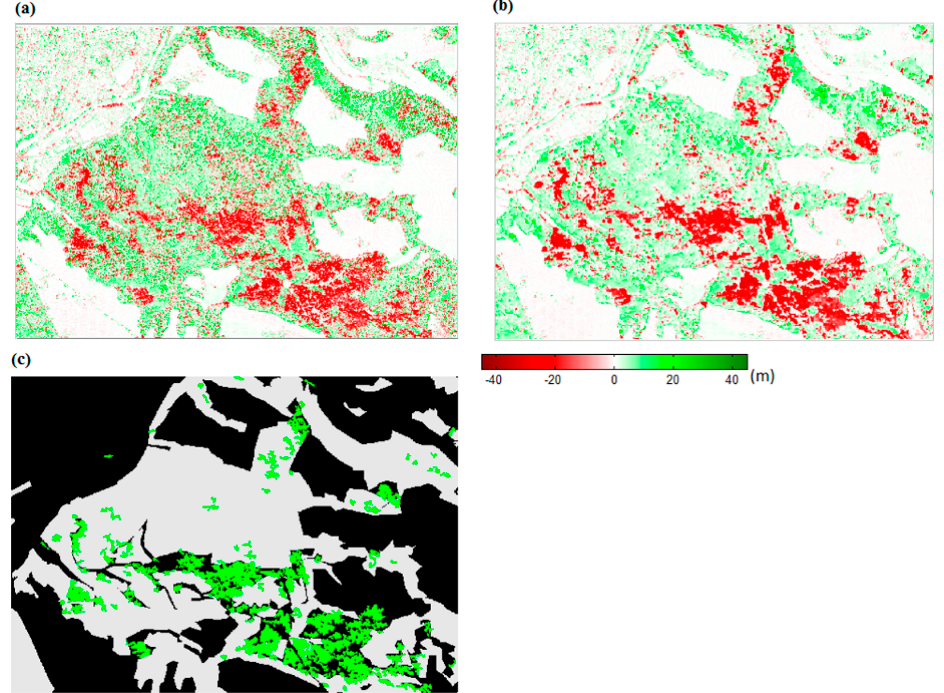
Figure 7. Reference change mask generation procedure: ( a ) Original height difference map; ( b ) refined height difference map (in ( a , b ), the red areas represent a decrease in height, while green ones represent the increase in height and white represents regions with no height difference and no change); and ( c ) generated change reference mask (green: a decrease in height of 12 m or more; grey: forest mask extracted from WorldView-2 data).